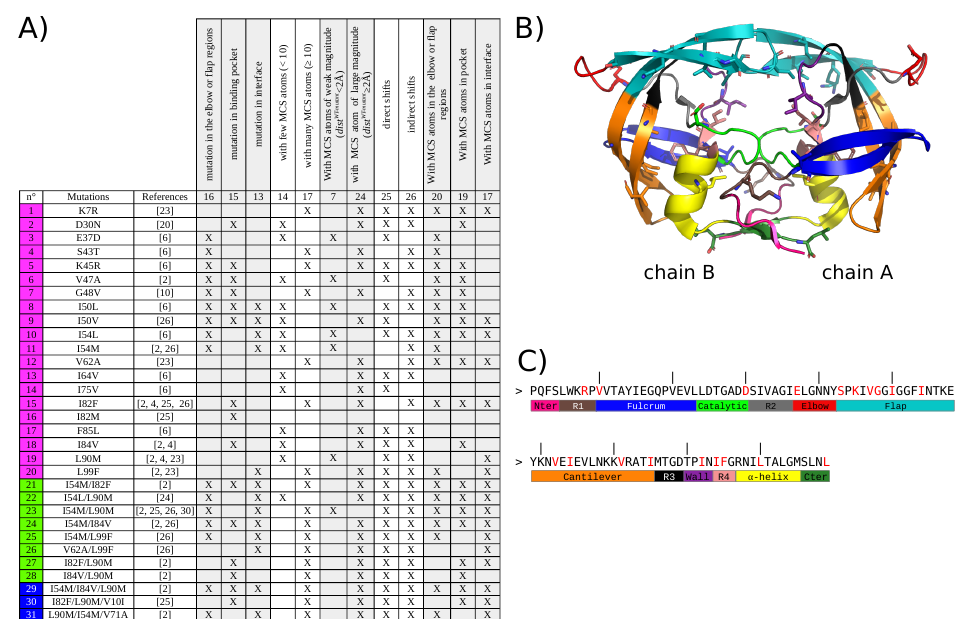
Figure 1. Description of the 31 drug-resistant mutants studied in this analysis. ( A ) Table listing the 31 drug-resistant mutants studied in this analysis. Single mutants are colored in magenta, double mutants in green and triple mutants in blue. ( B ) Location on PR2 structure of the 22 drug-resistance mutations included in the 31 mutant set. PR2 is represented in cartoon mode and colored according to the 13 regions defined in [34,35]. Mutations are represented in stick mode. ( C ) Amino acid sequence of PR2 presenting the limit of the 13 PR2 regions. All the mutated residues are colored in red in the